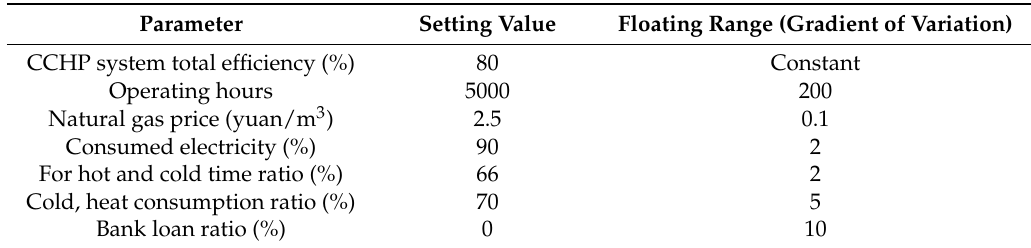
Table 8. Values and floating ranges of parameter in basic scenario.